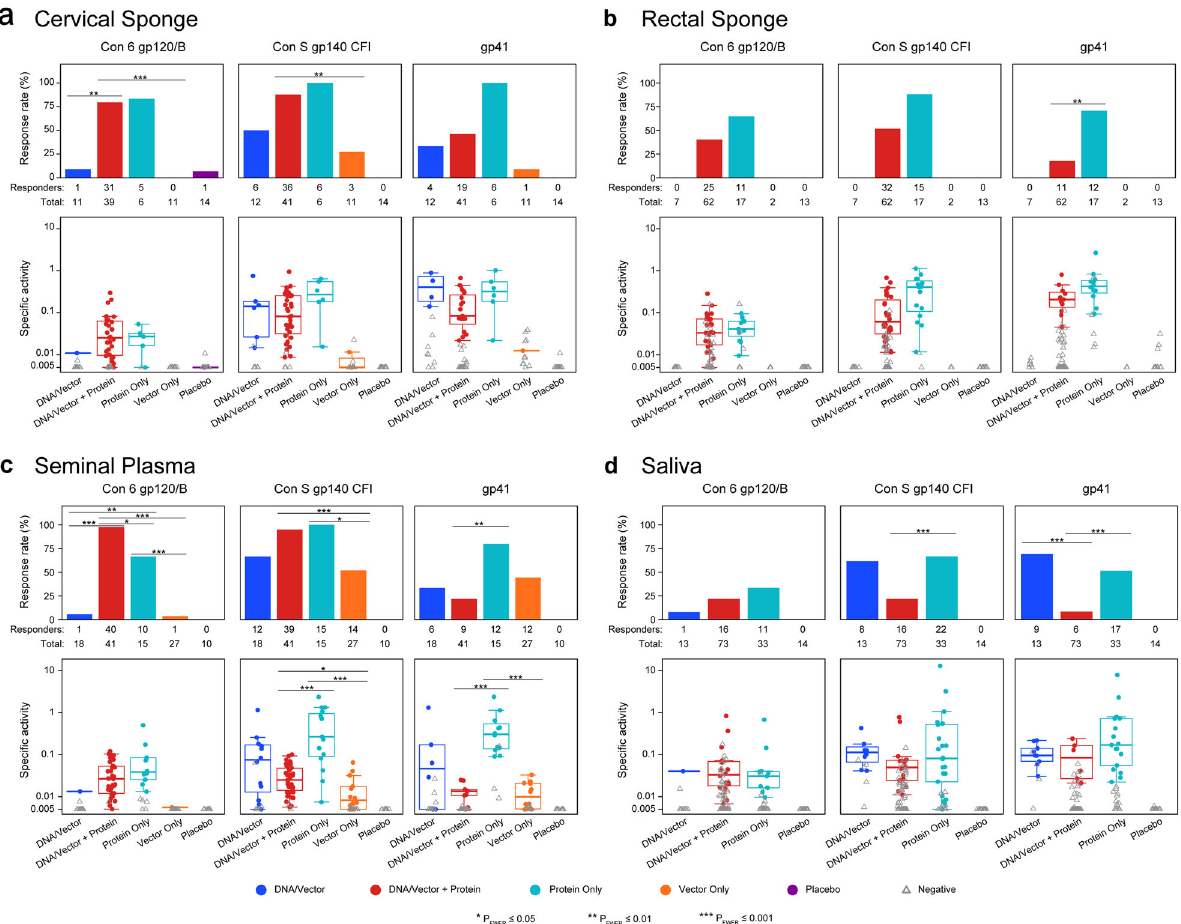
Fig. 1 Protein immunization elicits a high response rate of mucosal HIV-1 gp120 envelope-speci fi c IgG. HIV-1 envelope-speci fi c IgG (Con 6 gp120, Con S gp140, and gp41) were measured in secretions from a cervical sponge, b rectal sponge, c seminal plasma, and d saliva. The antibody magnitude was calculated as the HIV-speci fi c concentration relative to total antibody concentration, noted as speci fi c activity (SA = MFI*dilution/total IgG ng per mL). Top panels represent the response rates and bottom panels represent the response magnitudes (solid dots for positive responses and grey open triangles for negative responses). In the bottom panels, the mid-line of the boxplot denotes the median response magnitude and the ends of the boxplot denote the 25th and 75th percentiles among positive responses. Differences in the response rate between vaccine regimens were assessed using Barnard ’ s exact test and differences in response magnitude were assessed using the Wilcoxon rank-sum test. * P FWER < 0.05, ** P FWER < 0.01, and *** P FWER <